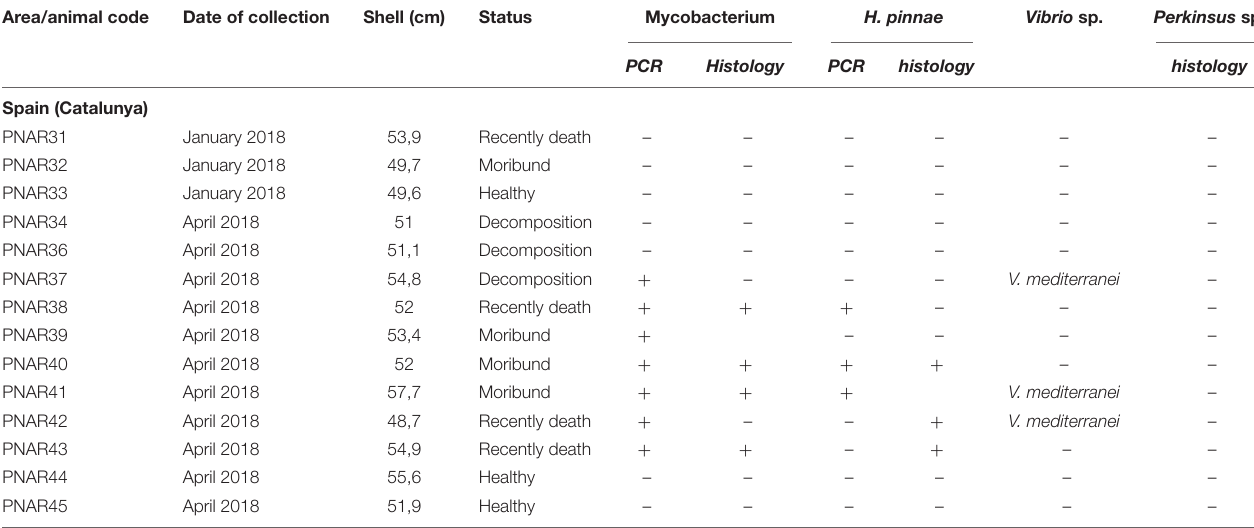
TABLE 3 | Sampling data of the 14 Pinna nobilis specimens from Catalunya analyzed in the study and results of the detection of Mycobacterium , H. pinnae and V. mediterranei by histology and/or molecular diagnostic. Area/animal